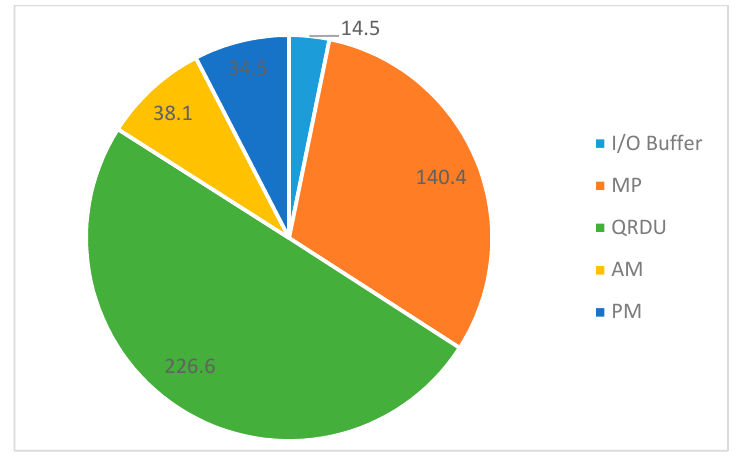
Figure 20. logic complexity breakdown of chip design. Figure 20. Logic complexity breakdown of chip design. Table 6. Performance comparison of related DoA estimation hardware